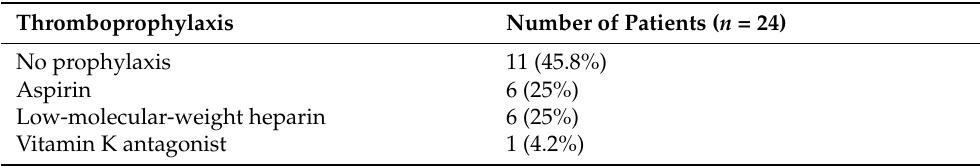
Table 3. Prophylaxis regimens at time of development of VTE. LMWH = low-molecular-weight heparin. VKA = vitamin K